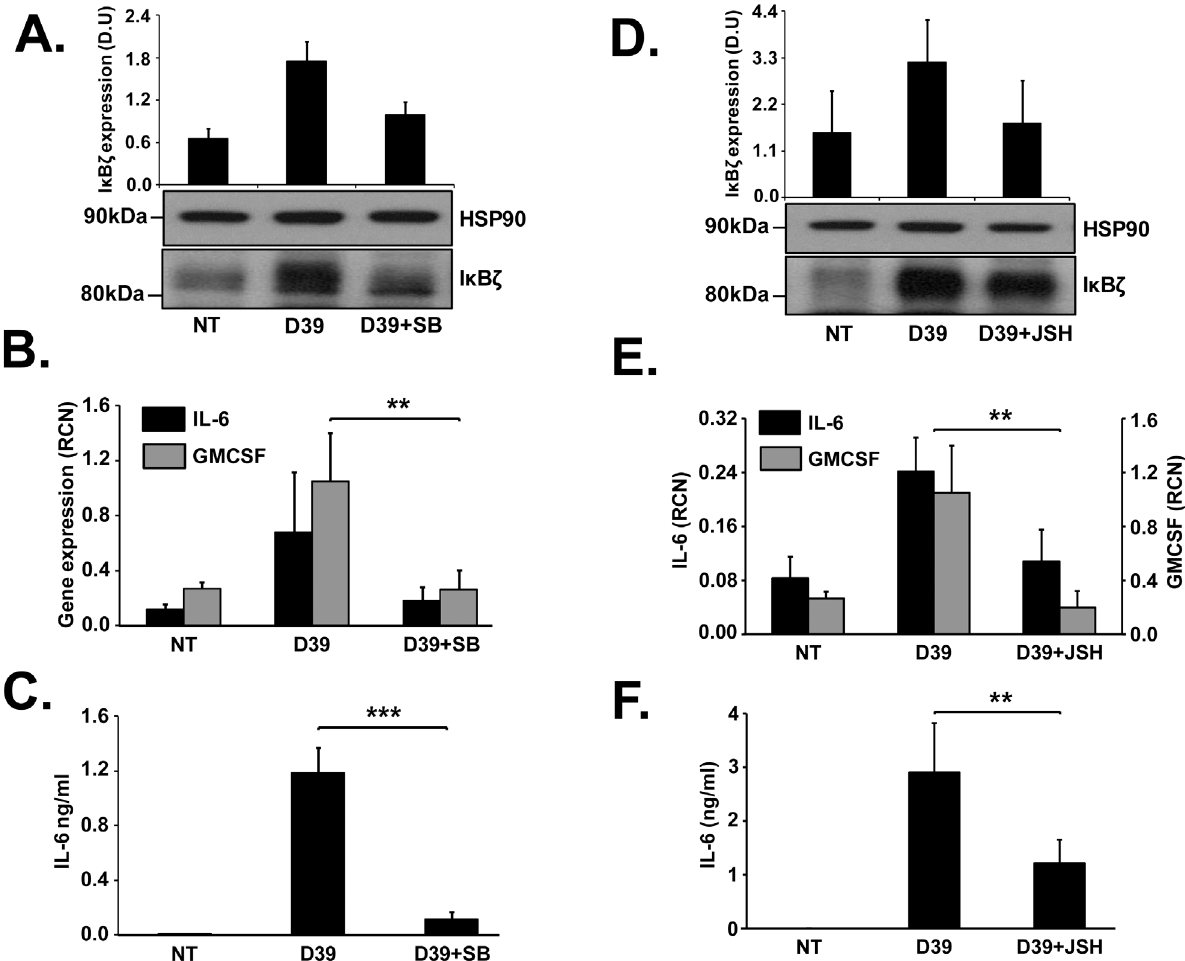
Fig 6. Upstream regulators of I κ B ζ mediated immune response to pneumococcus. Human monocytes (10 6 cells/ml) were (A-C) pretreated with the p38 MAP kinase inhibitor, SB203580 (SB; 10uM) or (D-F) the NFKB inhibitorJSH23 (JSH; 40uM) for 30 minutes followed by infection with D39 at an MOI of 0.1 for 3 and 6 h. (A,D) Cell extracts were analyzed using quantification of protein expression by immunoblotting for I κ B ζ and loading control HSP90. (B,E) qPCR analysis for mRNA expression of IL-6 and GMCSF. (C,F) IL-6 release from the cells was analyzed using ELISA. The immunoblot represents 4 – 5 independent experiments and the bar graphs represent the mean ± SEM of 4 – 5 independent experiments. ** p (cid:1) 0.03, *** p < 0.01. NT stands for not